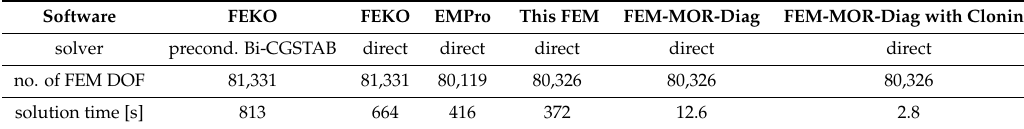
Figure 11. S-parameters obtained in the commercial software and this analysis ( a ); and a view of the tested structure meshed in FEKO ( b ). Table 3. The solution times for the commercial software and this